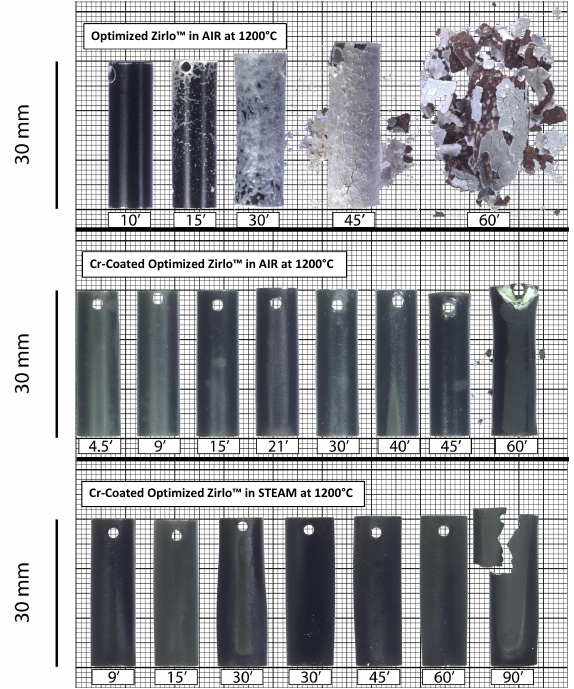
Figure 6. Photos of some samples after oxidation